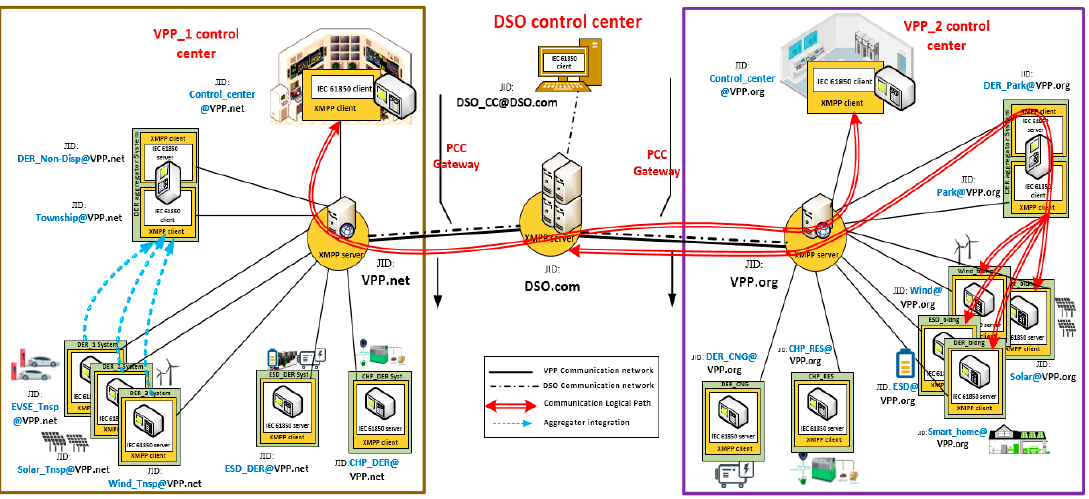
Figure 7. Federation link organized between multiple XMPP servers for VPP communication paths.